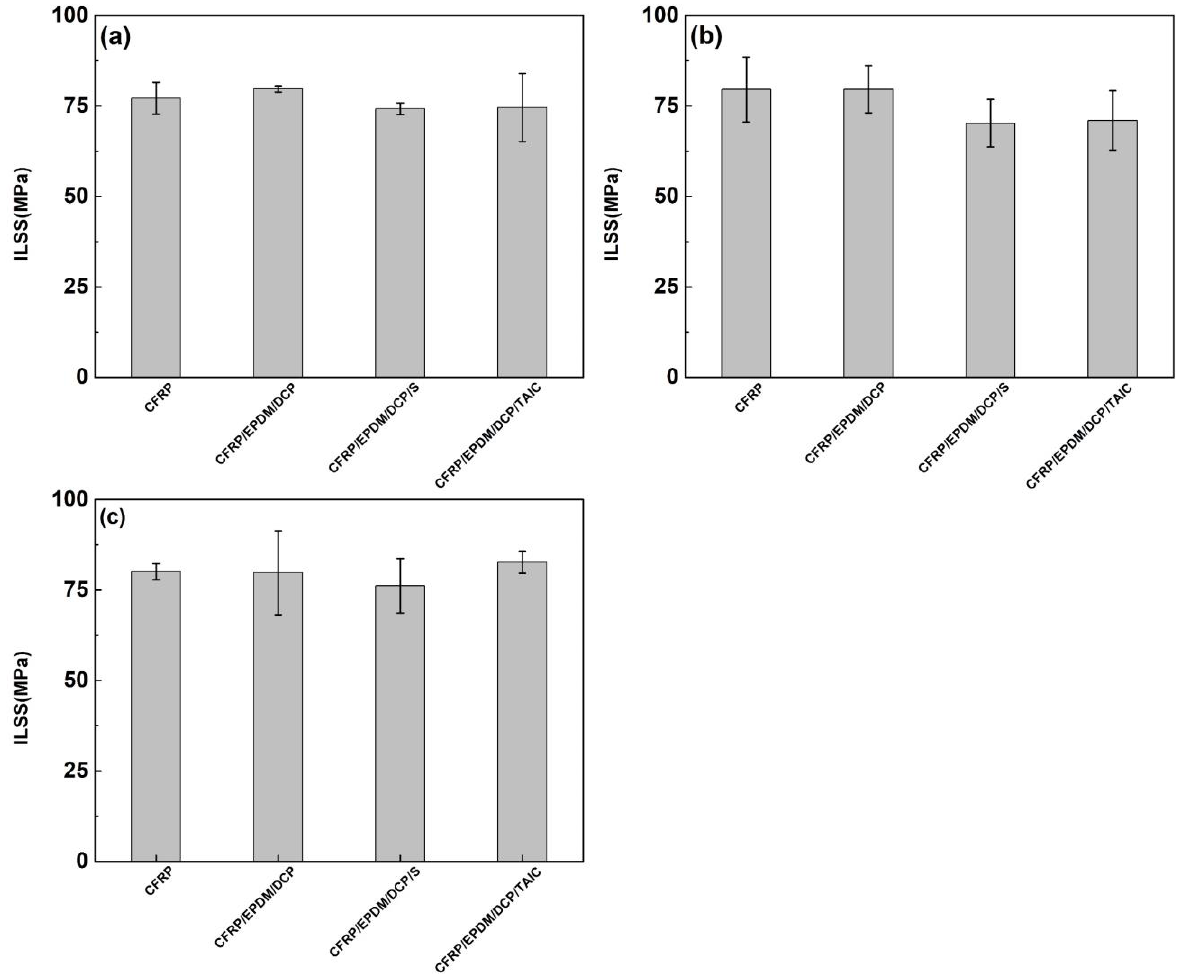
Figure 11. The ILSS of CFRP. ( a ) 160 °C, 1 h. ( b ) 170 °C, 1 h. ( c ) 180 °C, 1 h.